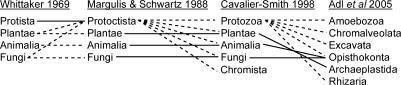
Trends in the Taxonomy of EukaryotesA comparison of four representative taxonomies illustrates trends within eukaryotic taxonomy over the past 50 years [2,5–7]. Movement of taxa is traced from earlier to more recent taxonomies with solid and dashed lines. A solid line indicates all members of a group (left of line) are incorporated into the subsequent group (right of line). Dashed lines indicate that a subset of members (left) is incorporated into subsequent groups (right).